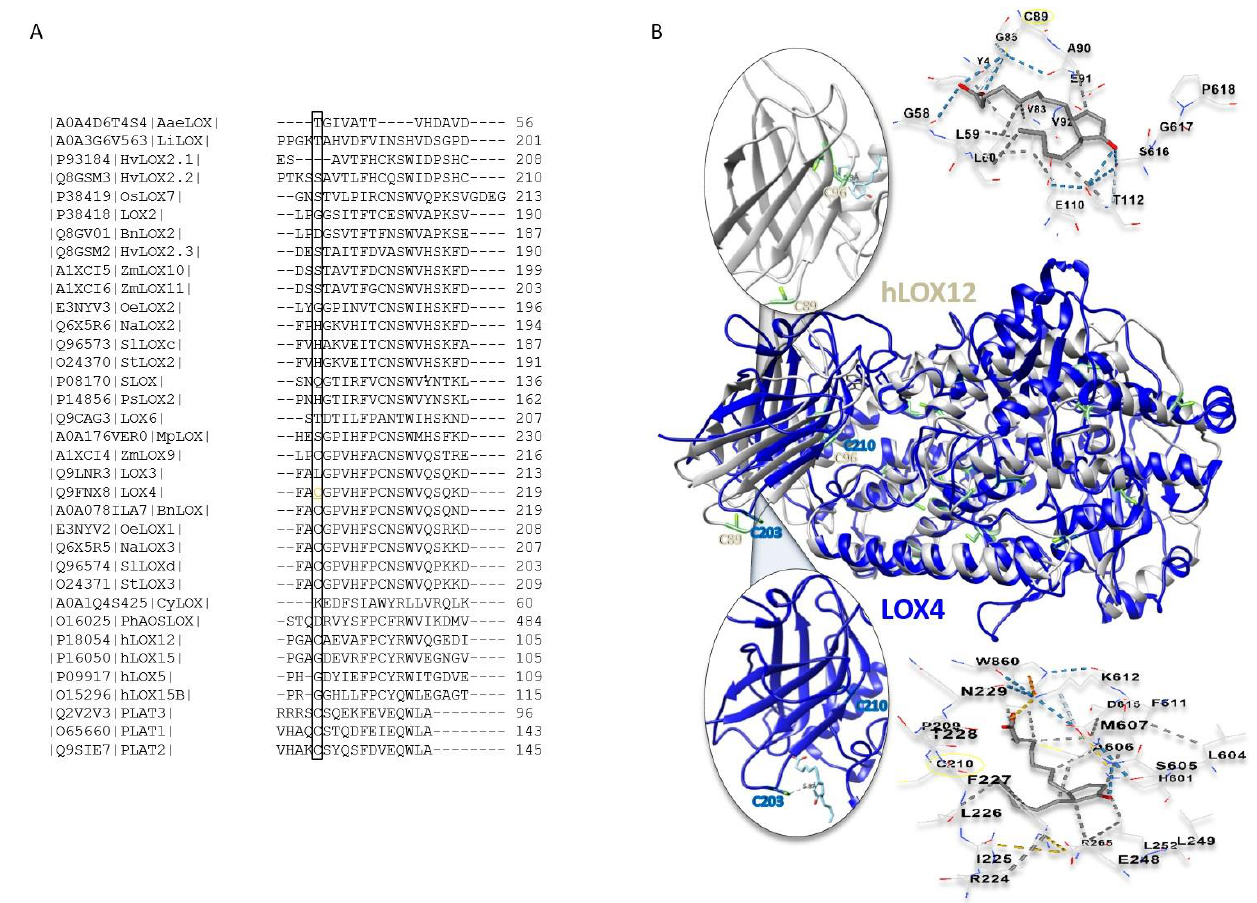
Figure 8. In silico analysis of LOX4, related proteins, and their interaction with the 12-OPDA. ( A ) Cys203 locates in the PLAT domain of LOX4 and is present in hLOX12, PLAT proteins and plant 13-LOXs, as revealed by multiple sequence alignment (not fully shown) with LOXs from fungi ( Agrocybe aegerita , Aae), algae ( Lobosphaera incisa , Li), cyanobacteria ( Calothrix sp. HK-06 , Cy), moss ( Marchantia polymorpha , Mp), anthozoa ( Plexaura homomalla , Ph), monocot ( Oryza sativa , Os, Zea mays , Zm, Hordeum vulgare , Hv) and dicot plants ( Glycine max , S, Brassica napus , Bn, Olea europaea , Oe, Pisum sativum , Ps, Nicotiana attenuata , Na, Solanum lycopersicum , Sl, Solanum tuberosum , St) and humans (h). Codes represent Uniprot/SwissProt IDs. ( B ) Structural alignment of LOX4 with LOX12, and blind docking studies with LOX4 and hLOX12, revealed that PLAT Cys (shown as sticks) are similarly positioned (<6 Å) and are addressed by 12-OPDA, with distances not exceeding 6Å (shown as a blue and grey stick model). The models were obtained by in silico studies with Swiss Dock and CB-DOCK online tools. One of the top 10 and top 5 possible docking modes is presented. LOX domains are not fully shown. The remaining Cys residues and the LOX stabilizing interaction between LOX4Trp213 and LOX4Arg327, Trp99 and Arg165 in hLOX12 are also presented with side-chains highlighted.